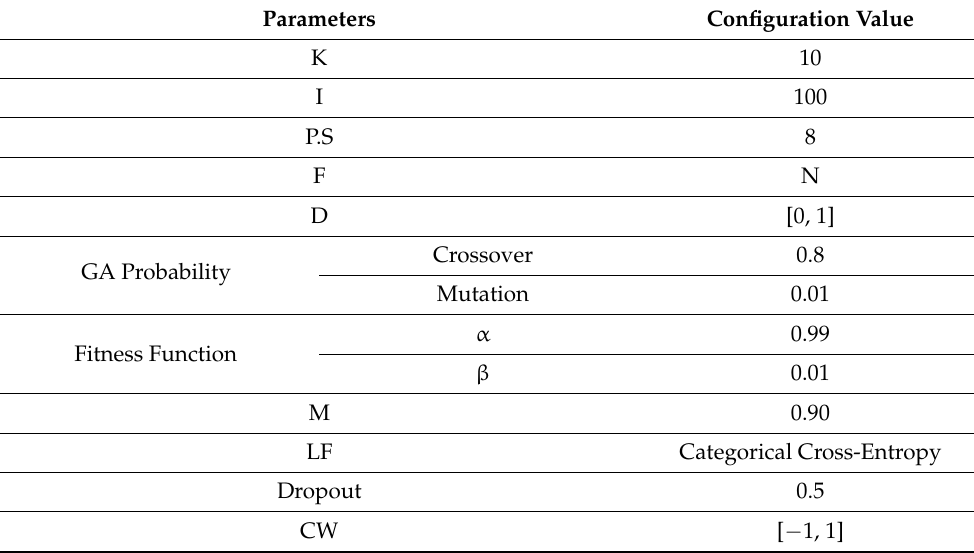
Table 3. The Details of Hyper Parameters